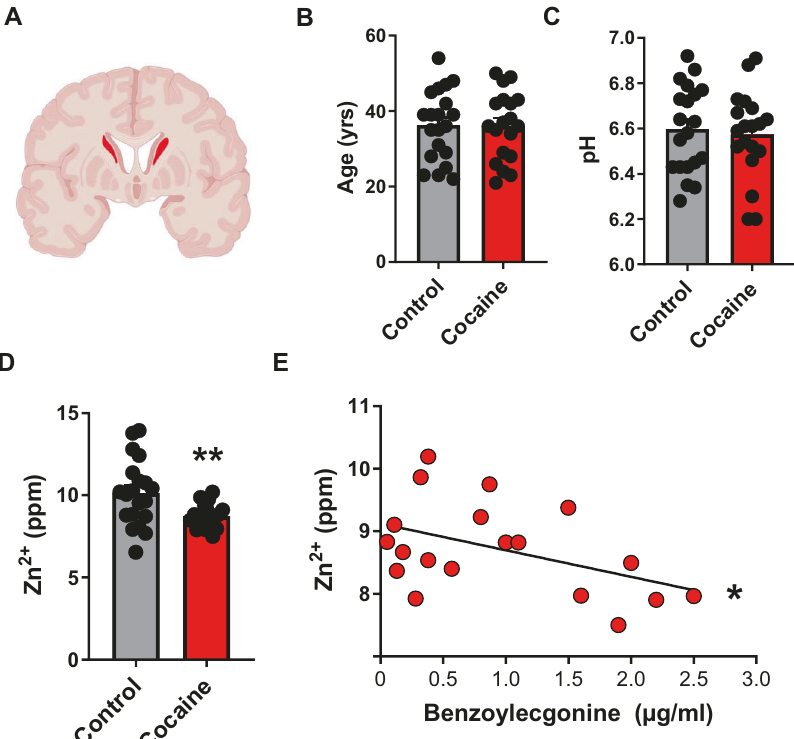
Fig. 1 Striatal Zn 2 + is low in human cocaine users and correlates with cocaine intake. A Schematic showing sampled region (caudate) from postmortem human brain samples. B Cocaine users and control subjects did not differ in age or ( C ) in tissue pH. ( D ) Cocaine users showed signi fi cantly lower striatal Zn 2 + levels compared to control subjects. ( E ) Striatal Zn 2 + levels in cocaine users signi fi cantly correlated with plasma benzoylecgonine levels (ppm – parts per million). **p ≤ 0.01, *p ≤ 0.05. All data expressed as Mean